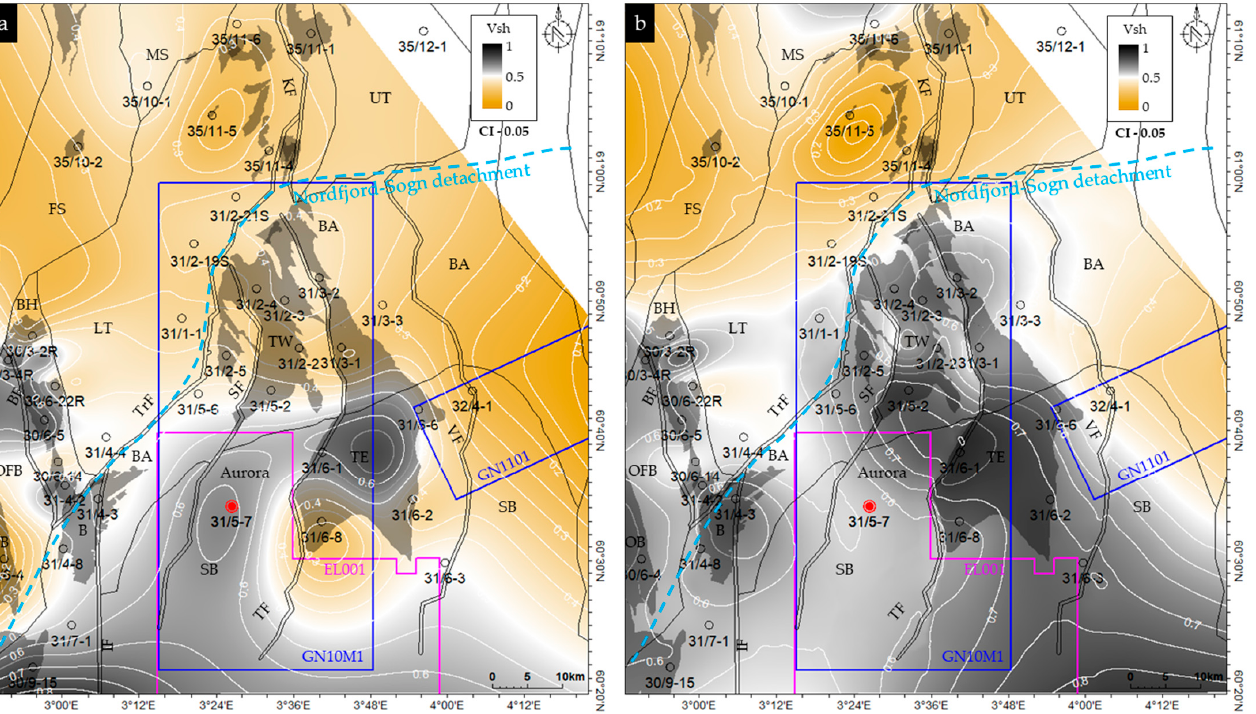
Figure 9. The normalized gamma-ray-based average volume of shale maps show the variation in the percentage of clays of the upper ( a ) and lower ( b ) Drake units. The contour interval (CI) in both maps is 0.05. The possible location of the Late Devonian Nordfjord–Sogn detachment extensional feature is also shown.